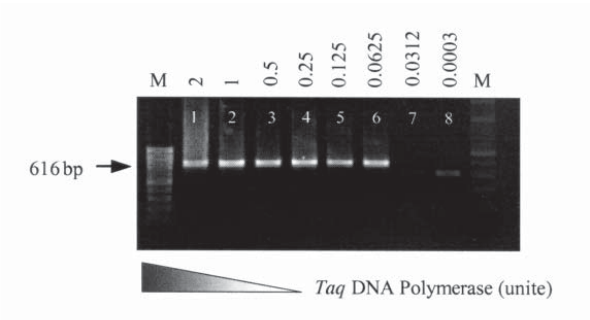
Fig. 3. Electrophoretic analysis of RT-PCR products de- riving from different Taq DNA polymerase concentra- tions. M, molecular size markers.